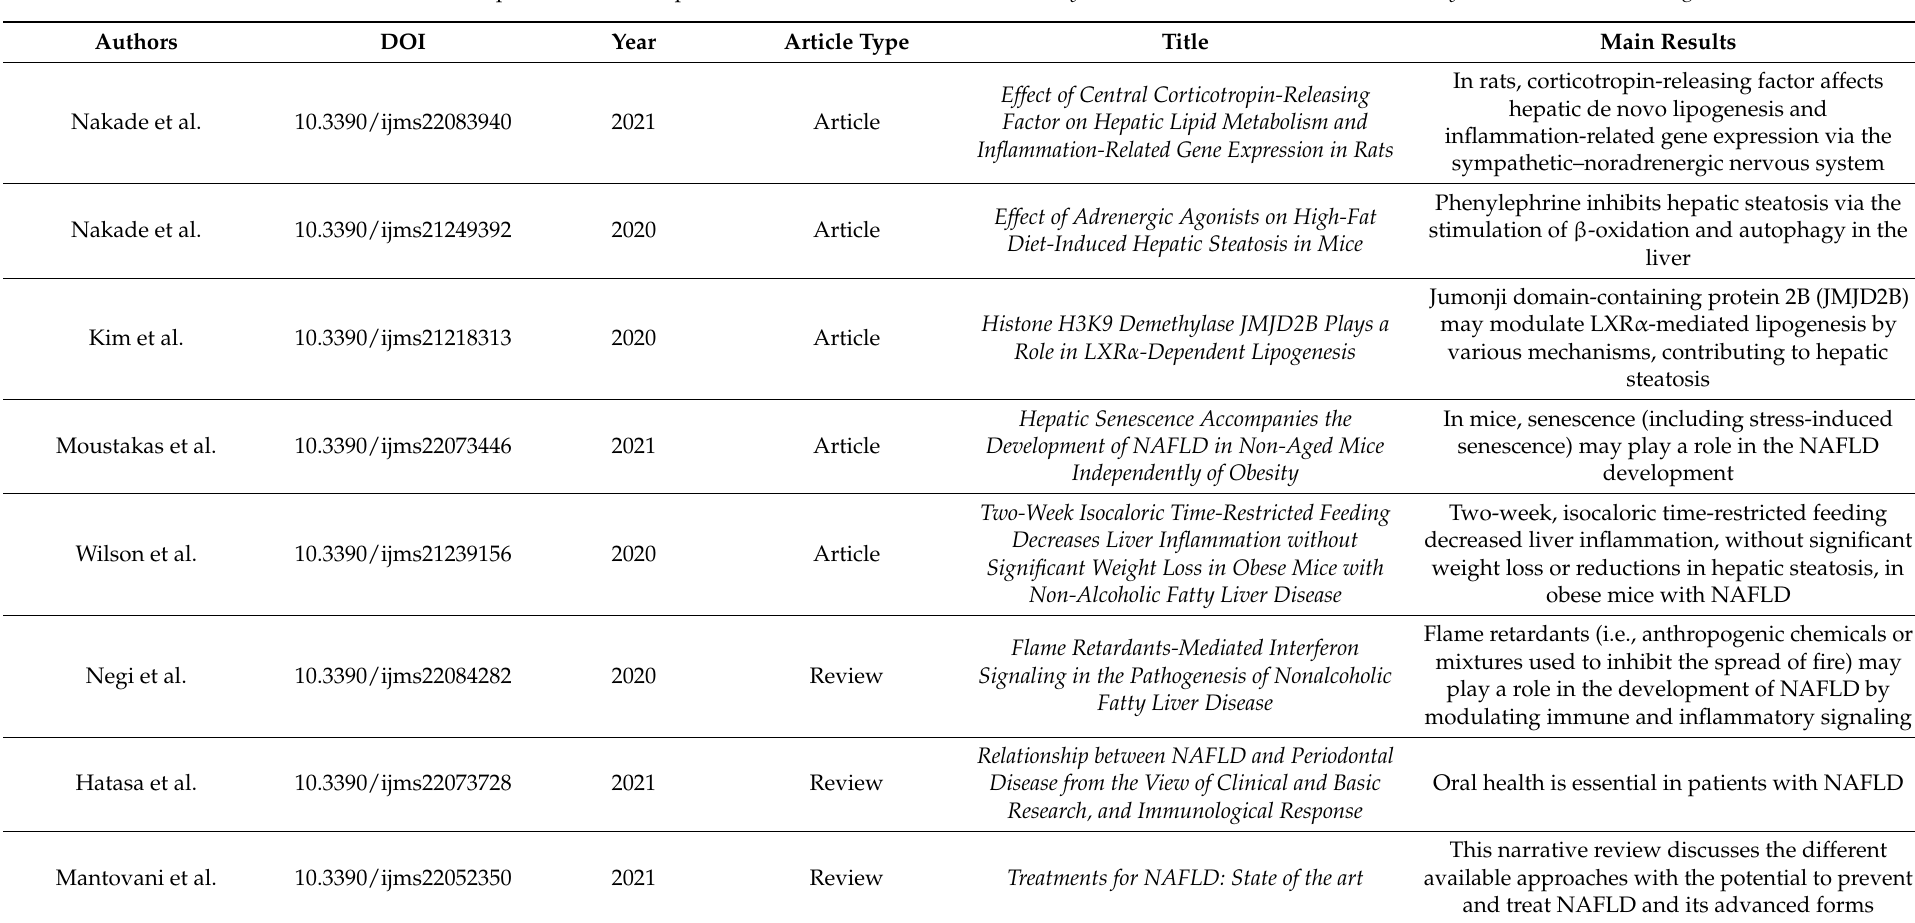
Table 1. Articles published in the Special Edition entitled “ Nonalcoholic Fatty Liver Disease/Metabolic Associated Fatty Liver Disease: New Insights